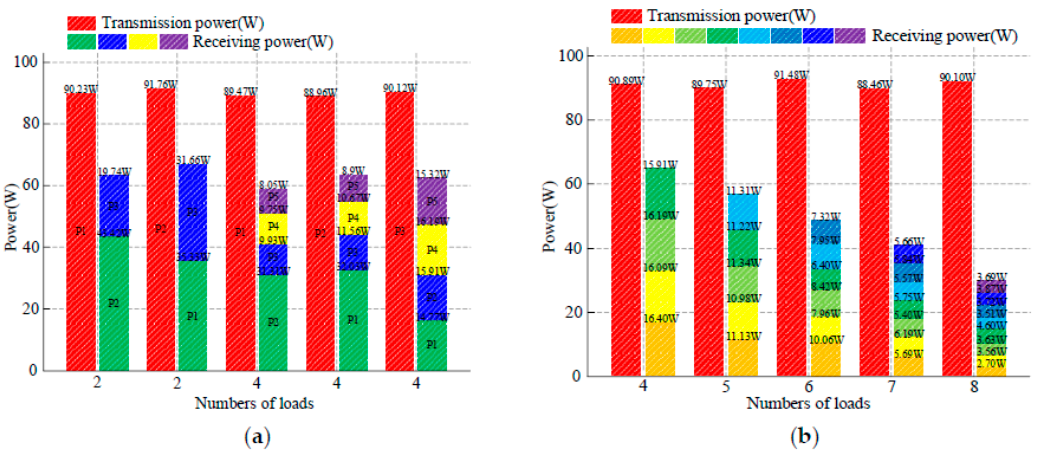
Figure 12. Experimental results of multi-load systems for ( a ) 5 m chained system and ( b ) 5 m emanant system.